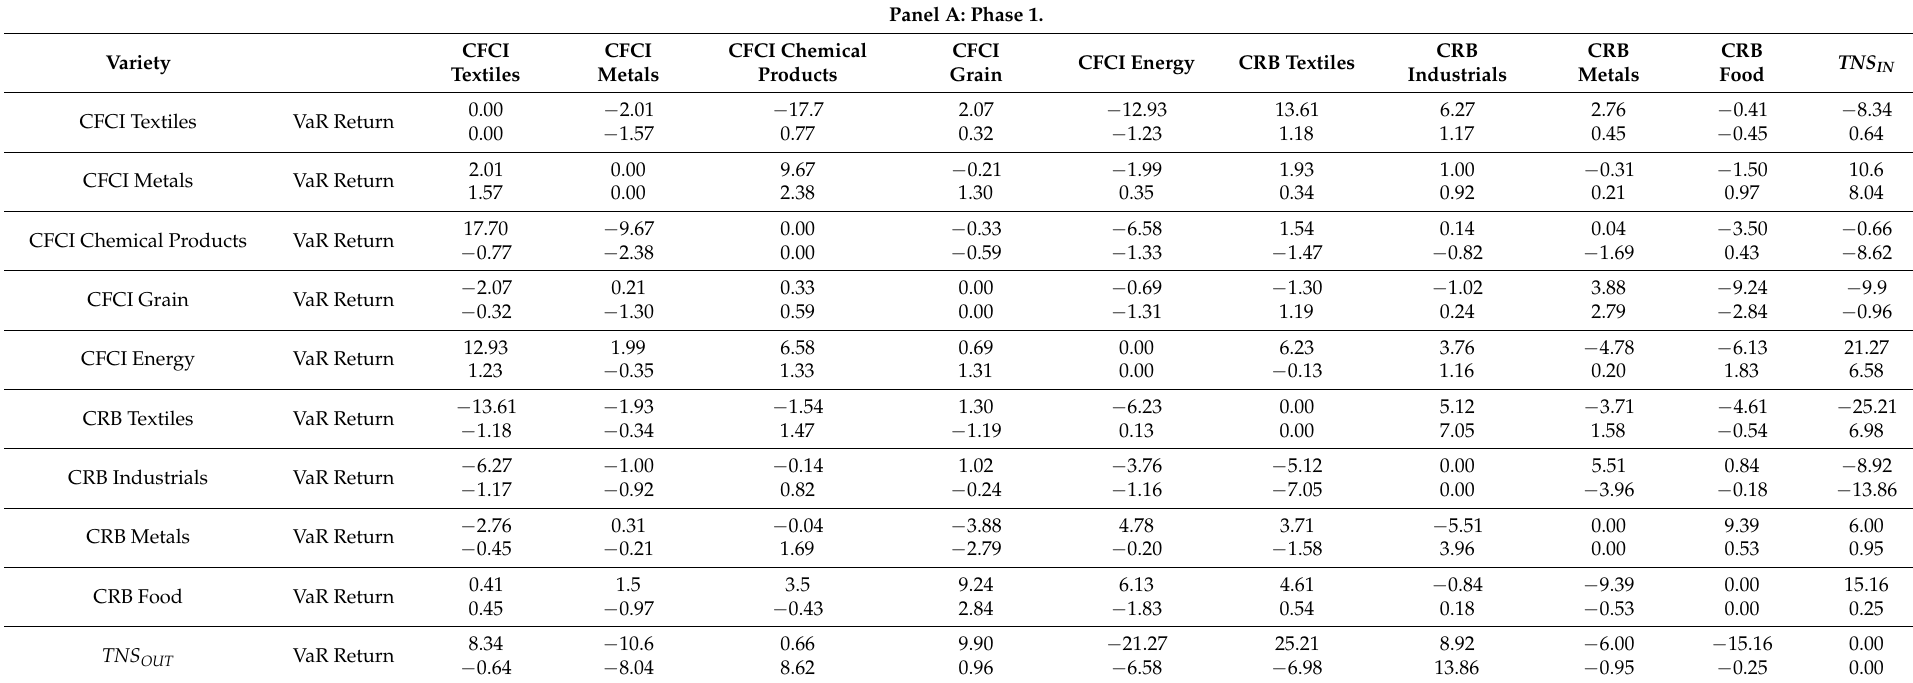
Table 4. The net volatility spillover between commodities over the three periods of the pandemic.